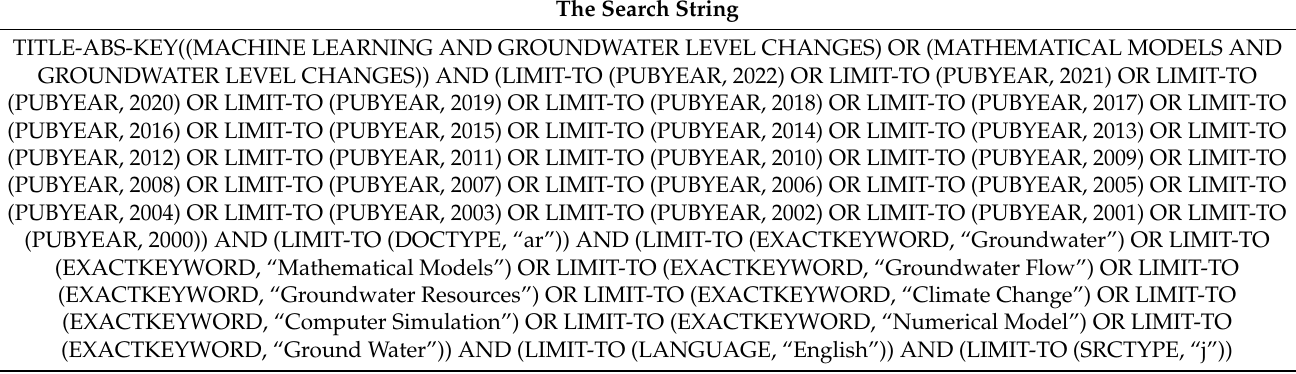
Figure 2. Steps of the systematic literature review’s analysis process .